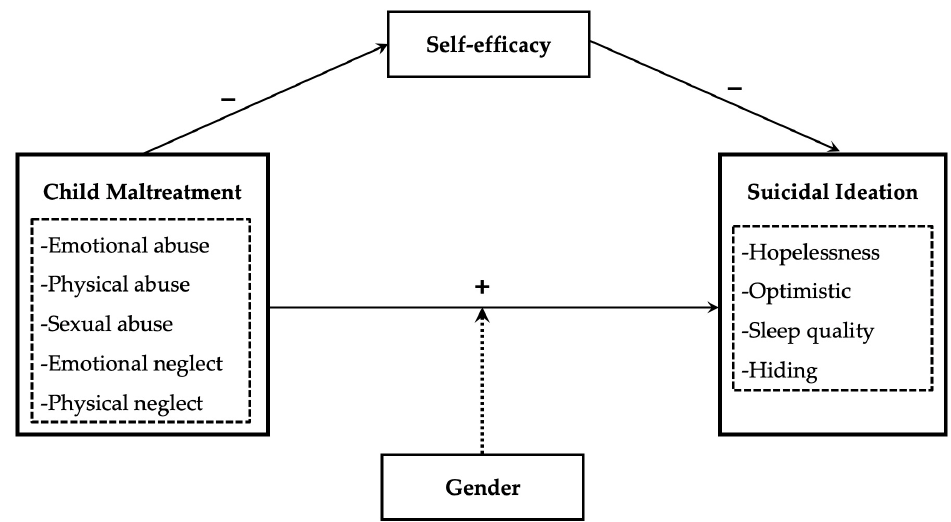
Figure 1. Theoretical